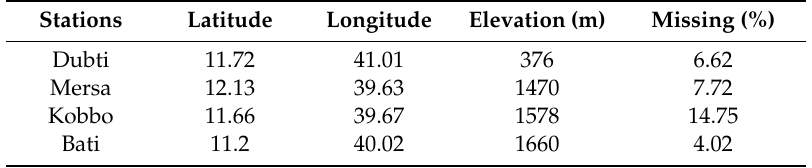
Table 1. Meteorological stations near the Logiya watershed and percentage of missing data. Stations